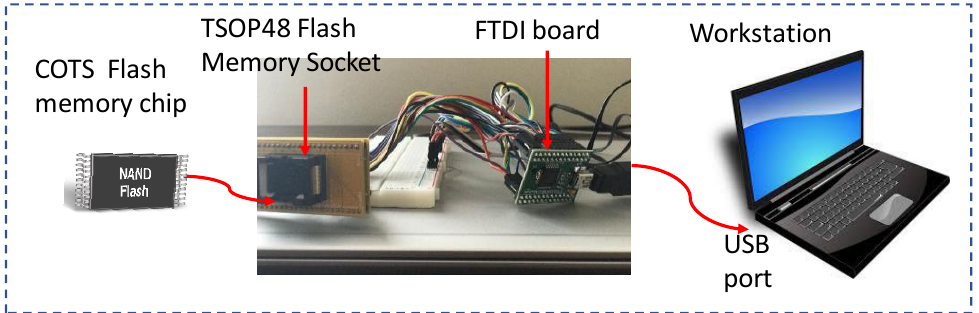
Figure 5. Experimental setup.